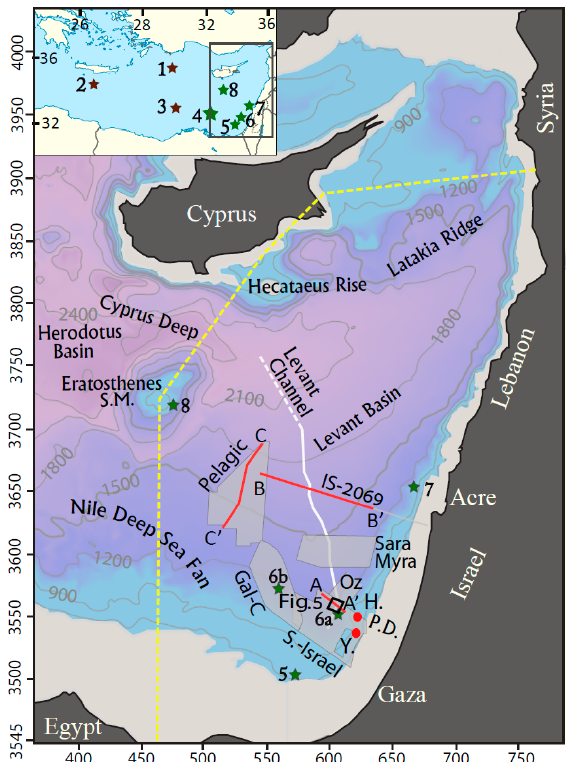
Figure 1. A color-coded and contoured bathymetric map of the Levant Basin [62], overlaid with the outlines of the 3D seismic blocks (gray areas) and the TGS IS-2069 seismic profile (gray line) analyzed in this work. The outlines of the seismic traverses displayed in Figures 6–8 are marked (red lines) and labeled. Also marked are the locations of Hanna (H.) and Yam (Y.) wells (red dots), the outline of Figure 5 (black rectangle), and the northern and western border of the study area (yellow dashed line). The inset (upper left corner) displays a map of the Eastern Mediterranean Sea (EMS), marked with natural gas hydrates (NGH) (brown stars) and methane seepage (green stars) observations locations: 1. The Thessaloniki mud volcano and Anaximander Seamount region (e.g., [33,63,64]); 2. the Olimpi mud volcanos field (e.g., [33], and references therein); 3. observations of hydrates formation during sampling [65]; 4. the Nile Delta and deep sea fan seepage domain (e.g., [66,67]); 5. seafloor seepage o ff shore the Sinai Peninsula [68]; 6. (a) the Palmahim disturbance (P.D.) and Levant Channel (white line), and (b) Gal-C, seepage sites [69–71]; 7. methane sampling o ff shore acre [70]; 8. Eratosthenes Seamount seepage sites [72,73]. The main map is plotted in UTM coordinates (zone 36N, datum WGS84) and labeled in km, while the inset is plotted in geographical